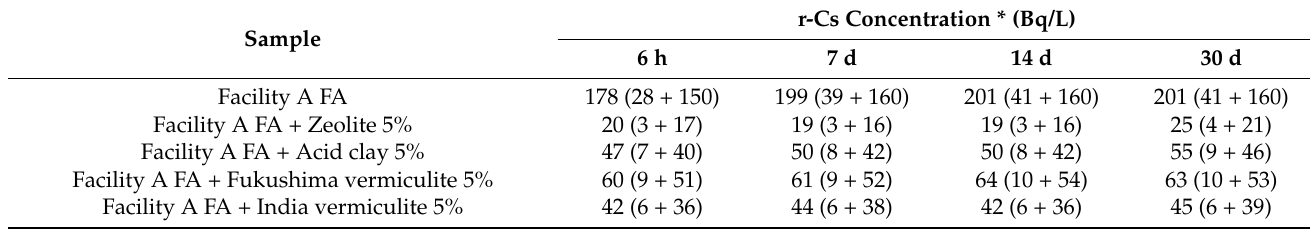
Table 11. Radioactive cesium (r-Cs) leaching test results (chelate-treated fly ash, TFA + 5 wt.% clay minerals). Sample